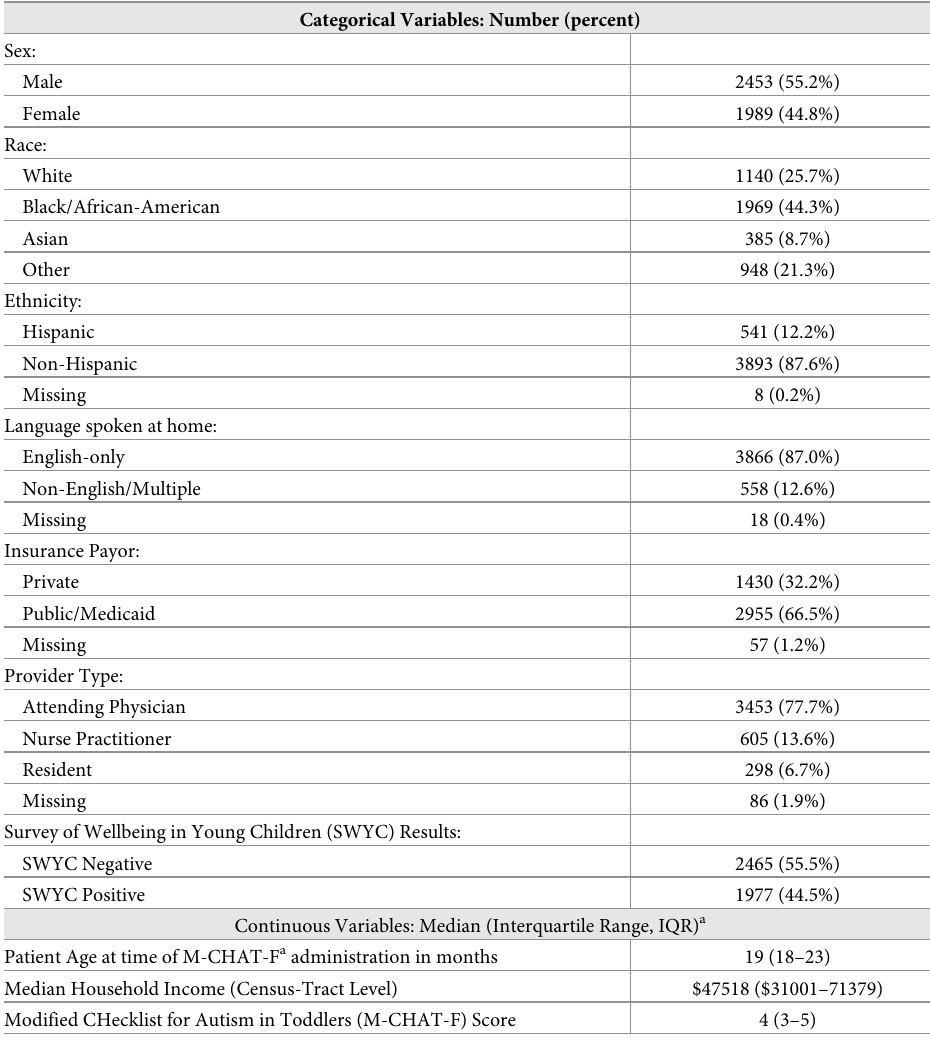
Table 1. Sample characteristics (N =